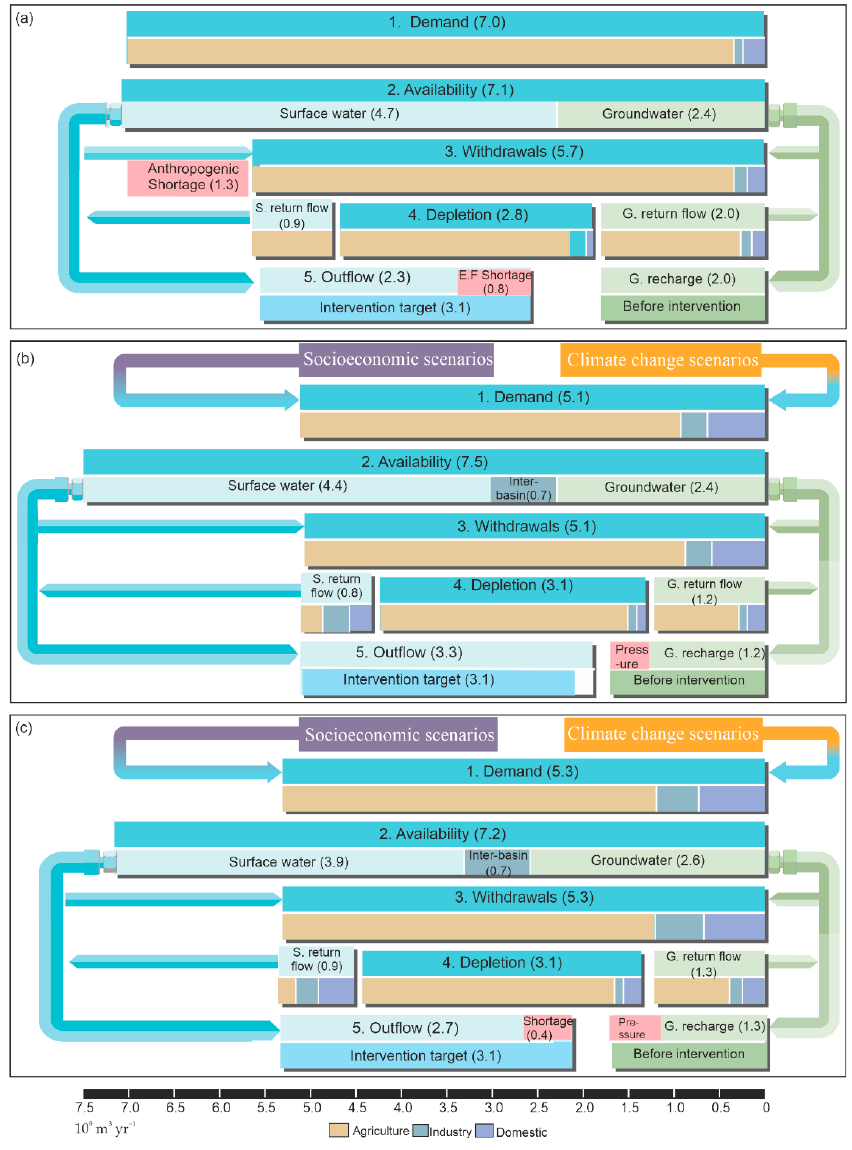
Figure 6. The water-saving strategies assessment (WSSA) framework for ( a ) ex-ante of the intervention (2000–2010) and ex-post of the intervention (2020–2030); ( b ) the RCP2.6 and business-as-planned socioeconomic scenarios and ( c ) the RCP8.5 and business-as-usual socioeconomic scenarios.